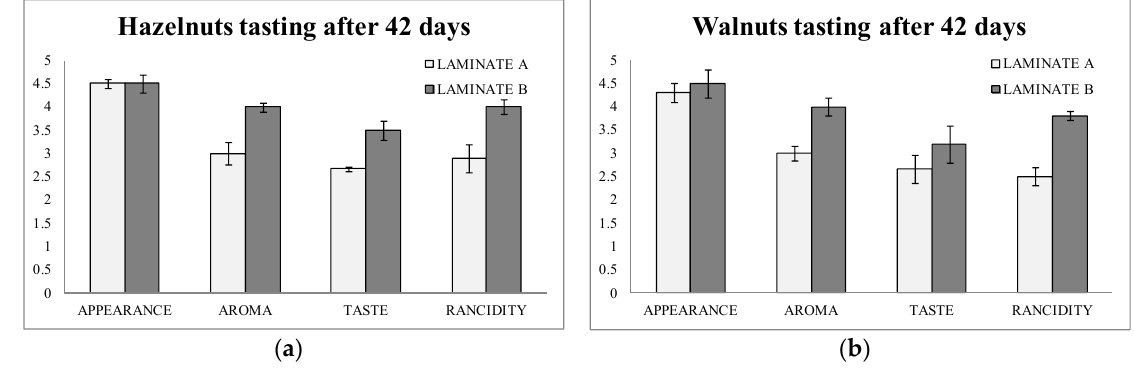
Figure 3. ( a ) Sensory evaluations of hazelnuts packaged in laminate A (control) and laminate B (actives with nanoselenium particles) after 42 days; ( b ) Sensory evaluations of walnuts packaged in laminate A (control) and laminate B (actives with nanoselenium particles) after 42 days.